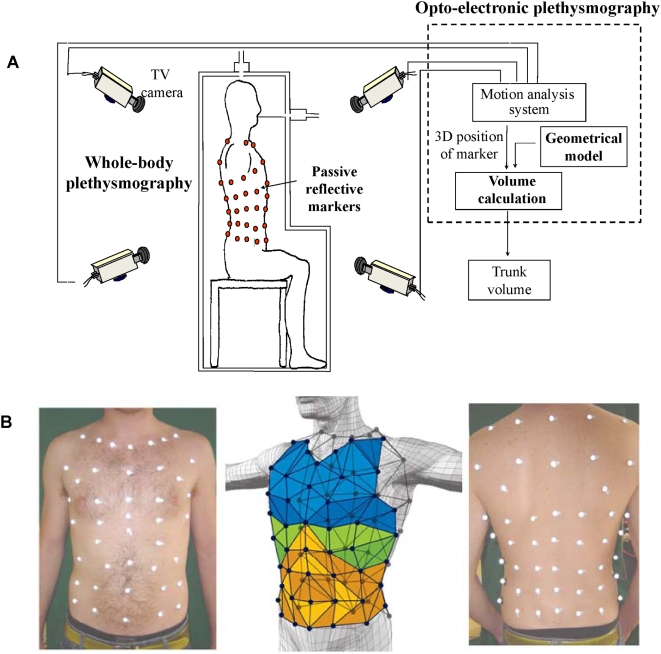
Experimental set-up.3-A Schematic diagram of the experimental set-up used to measure Vbs as the difference between changes in body volume and trunk volume (ΔVb-ΔVtr). ΔVb and ΔVtr are measured simultaneously by whole body plethysmography and Opto-electronic plethysmography (OEP), respectively. OEP is based on a motion analysis system which measures the 3D positions of 89 reflective markers positioned on body surface by a set of TV cameras, and computes the volume of the trunk by Gauss's Theorem. 3-B Marker positions on the anterior (left photograph) and posterior (right photograph) trunk surface. In the middle figure a diagram of the thoraco-abdominal surface triangulation is shown.